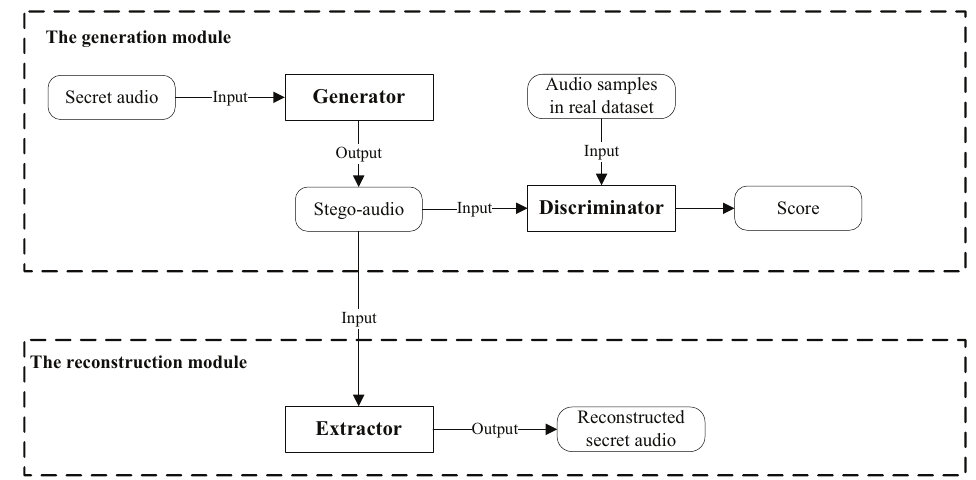
Figure 1. The model of the proposed